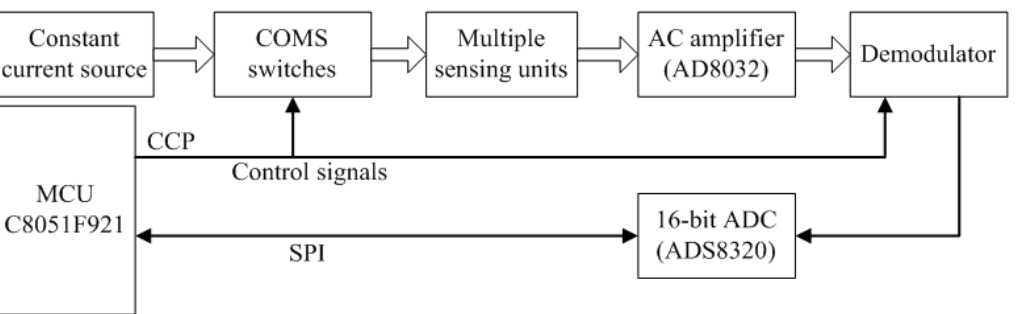
Figure 4. System block diagram of the RIP